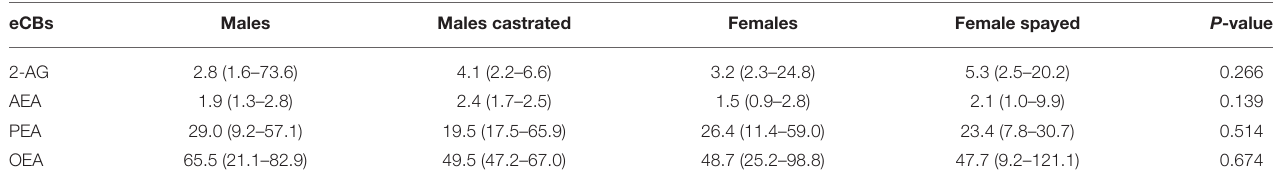
TABLE 5 | Median values, with minimum and maximum in brackets, of plasma endocannabinoids (eCBs) inin healthy females ( n = 10), spayed females ( n = 9), males ( n = 8), and castrated males ( n = 3).